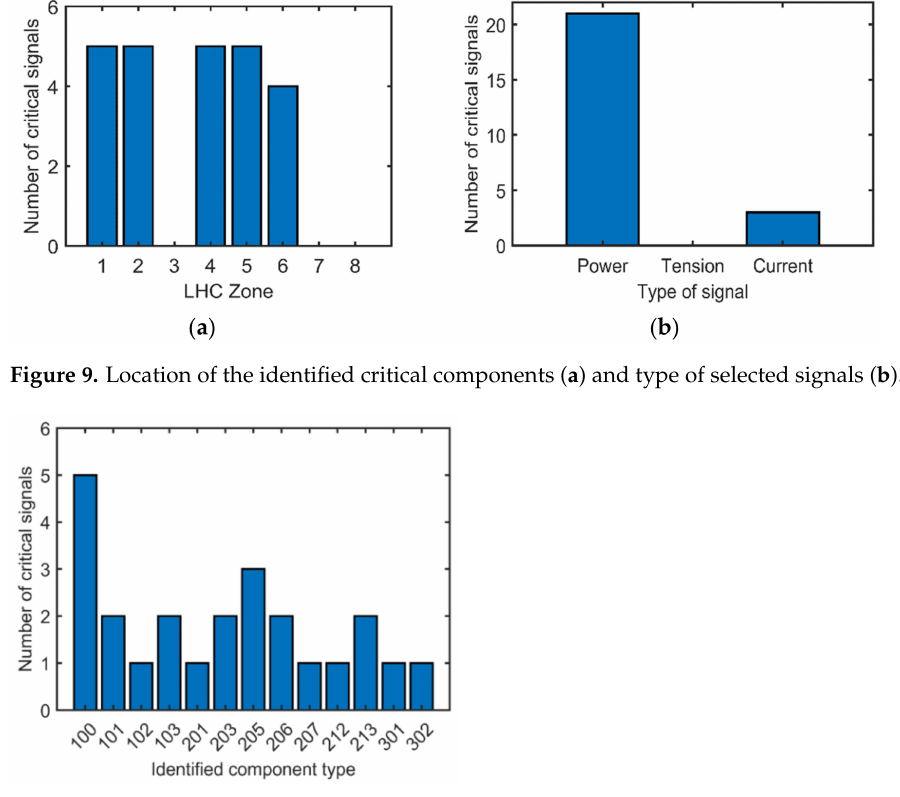
Figure 10. Number of critical signals associated with each identified type of